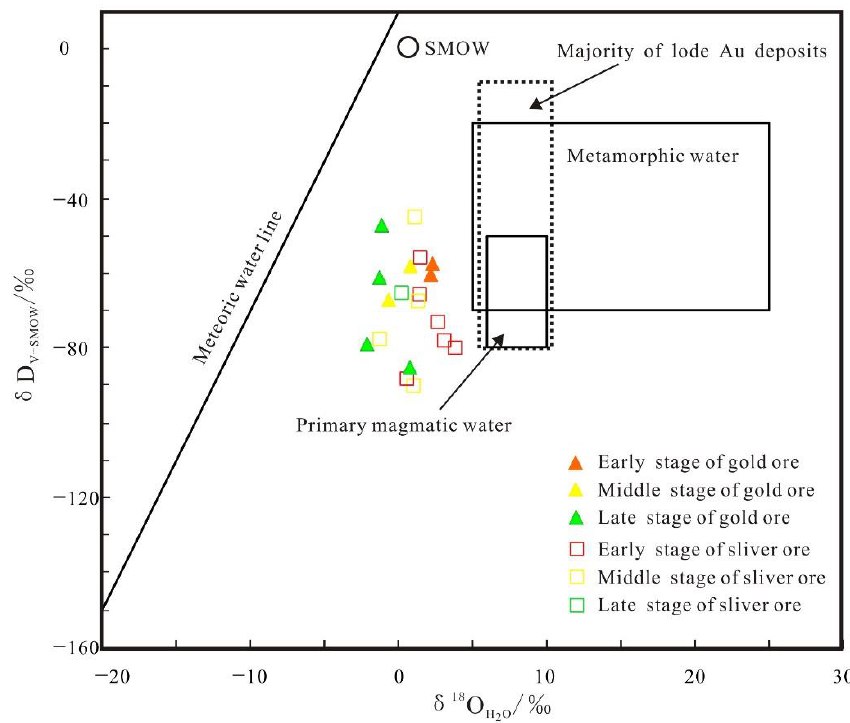
Figure 11. Plot of δD vs. δ 18 O H 2O for the Changkeng – Fuwan Au-Ag deposit (from [70]).